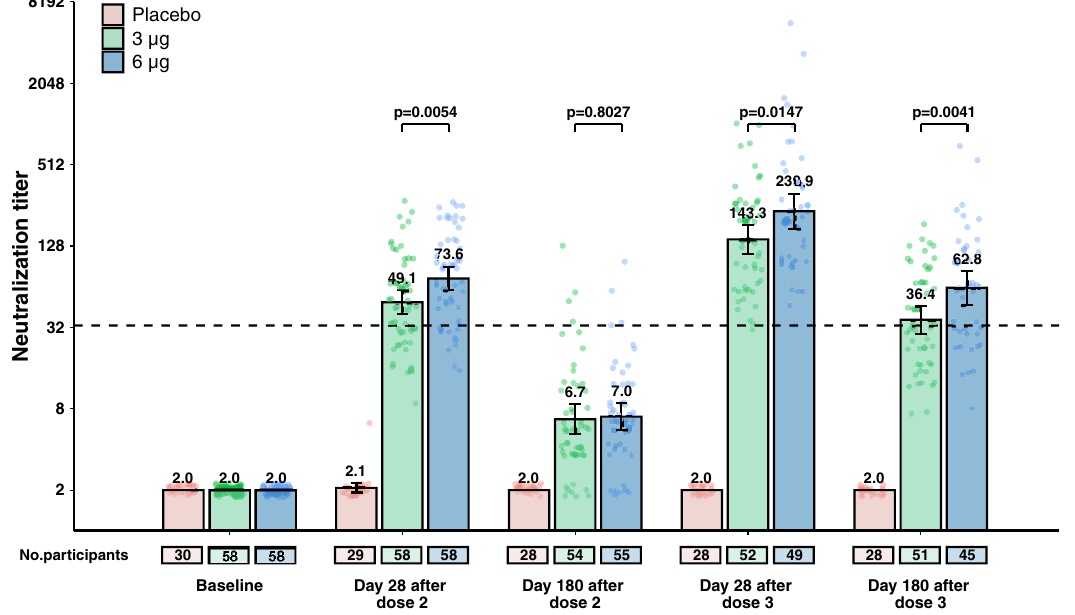
Fig. 1 Neutralising antibody levels to ancestral SARS-CoV-2 in cohort 2b-28d-8m (adults aged 18 – 59 years old). The number of participants for each group (placebo group, pink; 3 μ g group, green; 6 μ g group, blue) at each visit included in the analysis is provided below the bars. Dots are reciprocal neutralising antibody titres for individuals in the per-protocol population. Numbers above the bars are geometric mean titres (GMTs), and error bars indicate 95% CIs. GMTs and corresponding 95% CIs were calculated on the basis of standard normal distributions of log-transformed antibody titres. Numbers above the short horizontal lines are p values for comparisons between 3 μ g group and 6 μ g group using group t tests with log-transformation (two-sided). Titres lower than the limit of detection (1:4) are presented as half the limit of detection. The dotted horizontal line represents the protective threshold